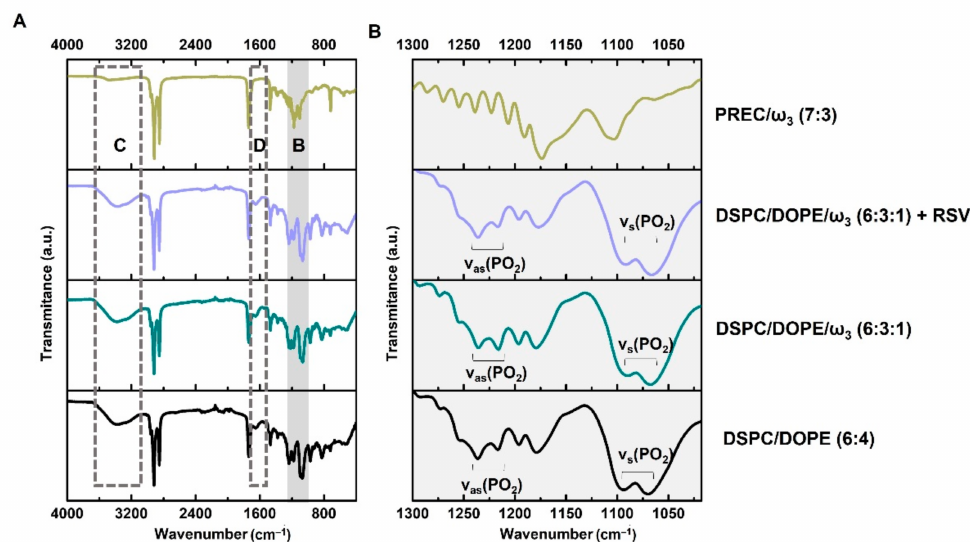
Figure 4. ATR-FTIR spectra of lipid nanosystems with and without ω 3 and RSV ( A ). The typical vibrations of the chemical groups ν s (CH 2 ) at 2850 cm − 1 and ν as (CH 2 ) at 2916 cm − 1 are present in all lipid nanosystems. Regions B (vibrations of the phosphate group of liposomes headgroups), C (band ν (N–H) at 3370 cm − 1 attributed to the choline phospholipids), and D (band δ as (N–CH attributed to the choline phospholipids) are assigned to the regions where NLC and liposomes differ. ( B ) Maximization of phosphate vibrations (Band